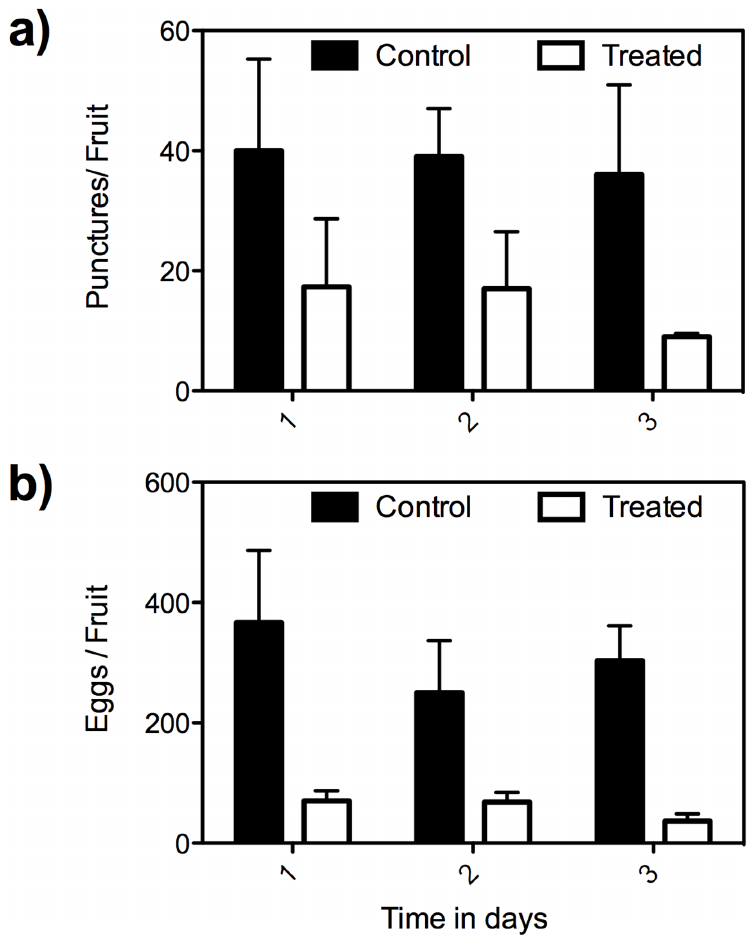
Fig 2. Effect of SA post treatment interval (days) on the oviposition of gravid female B . dorsalis . Repeated measures (mixed model) two-way ANOVA with Bonferroni post test (a) punctures ( F = 6.86; edf = 20; P = 0.03) (b) Eggs per puncture ( F = 130.20; edf = 20; P < 0.0001). Error bars = Standard error of